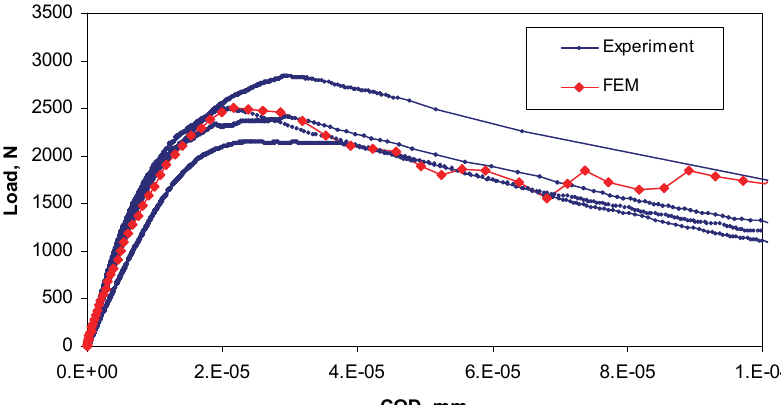
Figure 7: Load-crack opening displacement diagram of a three point bending test for plain concrete beam. Numerical and experimental